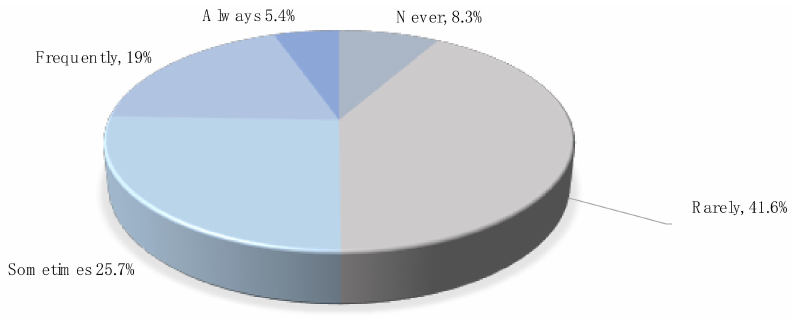
Figure 3. Percentages showing fake news perceived as distrust in slot ages of the participants. The distribution of fake news associated with media outlets was perceived for the total of the sample, as shown in Figure 4 (M = 2.72; SD = 1.037). General data show that a concerning 50% of the sample associated fake news with media outlets in different levels (Sometimes, 25.7%; Frequently, 19%, and Always, 5.4%).